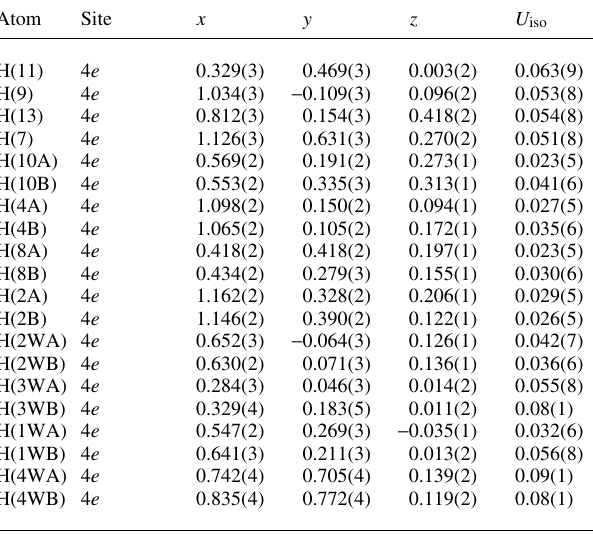
Table 2. Atomic coordinates and displacement parameters (in Å 2 )